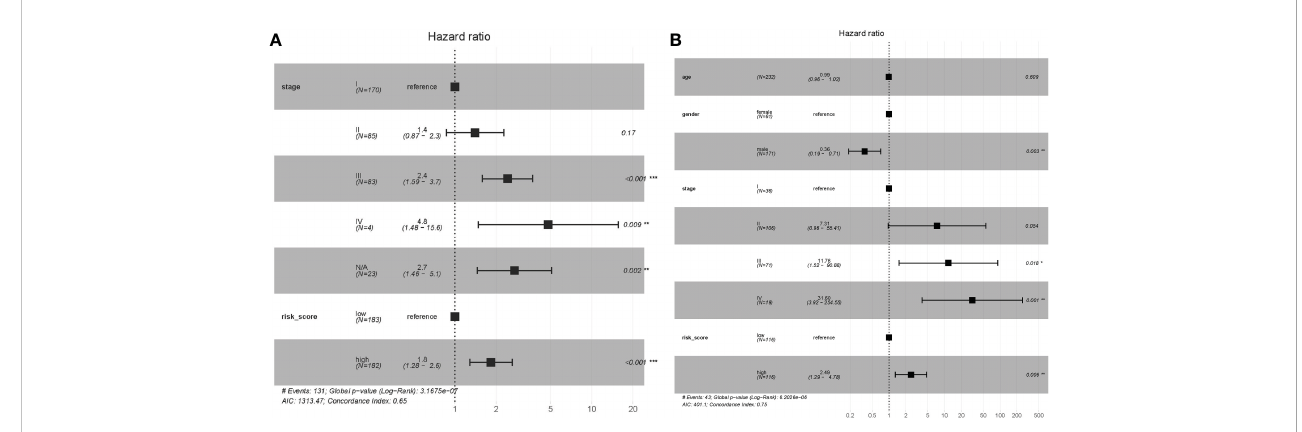
FIGURE 7 Multivariate independent prognostic analysis of independent risk factors for OS in patients with HCC. (A) Multivariate Cox regression analysis of the TCGA dataset. (B) Multivariate Cox regression analysis of the LIRI-JP dataset.